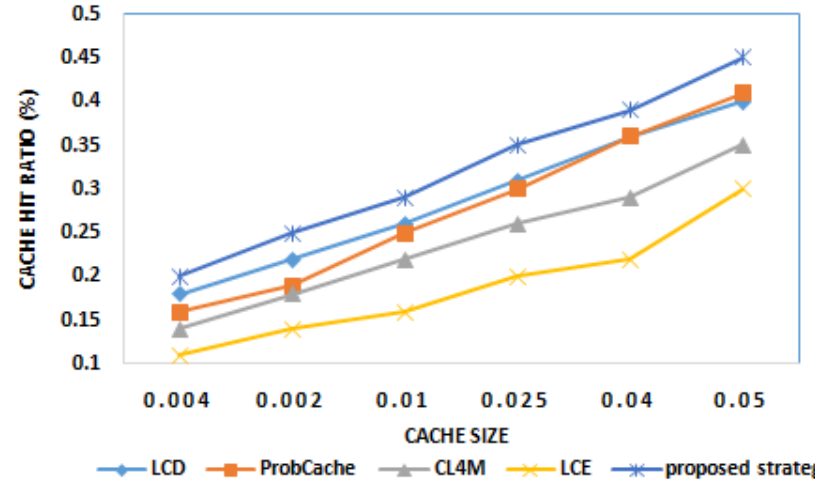
Figure 2. Cache hit ratio for different cache sizes.